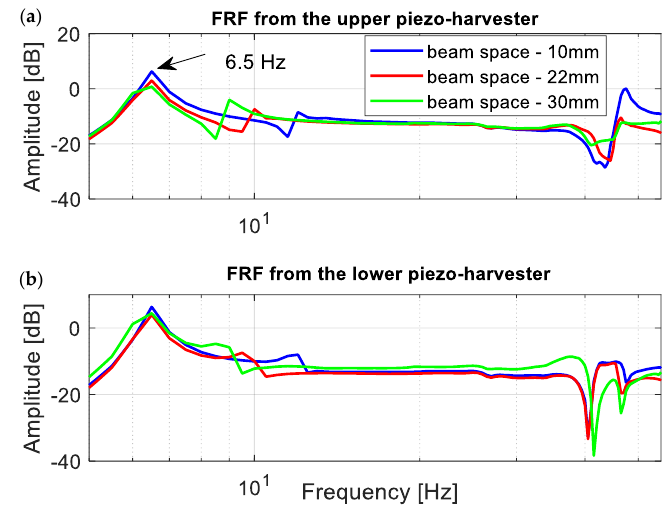
Figure 10. The comparison of the amplitude plot of the coupled magnetic beam structure with different beam spaces by using ( a ) upper harvester, ( b ) lower harvester.